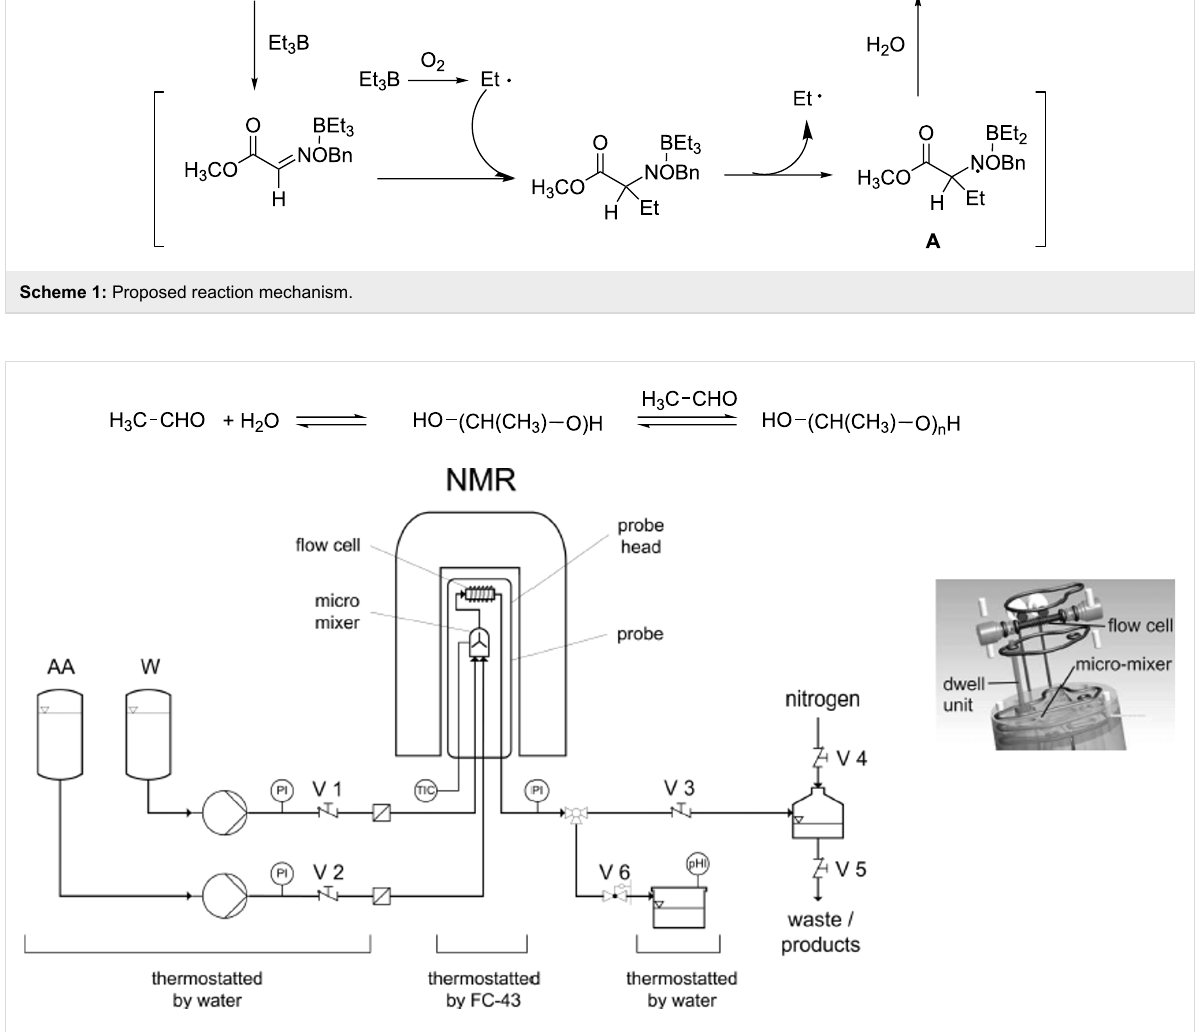
Figure 9: Flowsheet of the experimental setup used to study the reaction kinetics of the oligomer formation in mixtures of acetaldehyde (AA) and water (A) (Flow rates V AA 254 μ L min − 1 and V W 748 μ L min − 1 ). Reproduced with permission from reference [46]. Copyright 2014 The American Chemical